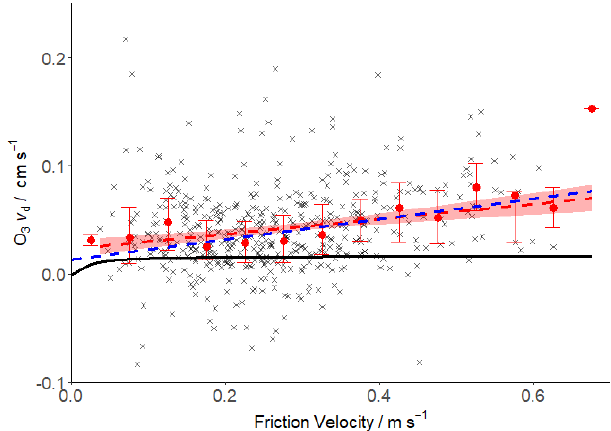
Figure 12. Deposition velocity dependence on friction velocity. 20min values are shown in grey. Bin-averaged median fluxes (0.05ms − 1 bins) are presented with interquartile ranges in red. De- pendence of O 3 deposition velocity on friction velocity is presented with a linear fit in red (95% confidence interval shaded), with the dependence predicted by Fairall et al. (2007) in blue and that pre- dicted by Luhar et al. (2018) in